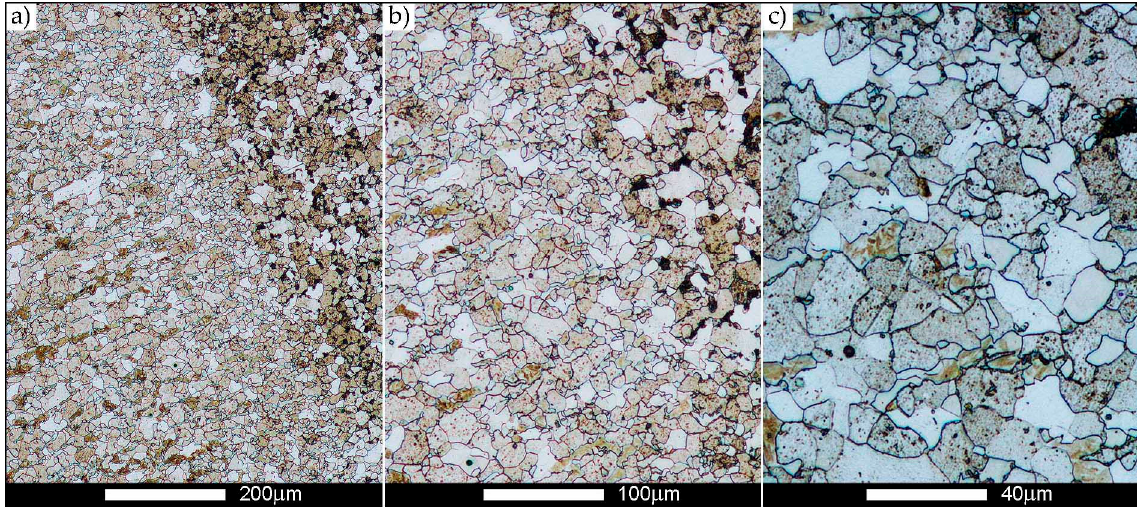
Figure 53. Welded joint microstructure of Hardox 450 steel with visible prior austenite grain boundaries, austenitised at 1000 °C—FL zone shown in Figure 2. ( a ) 100×; ( b ) 200×; ( c ) 500×.